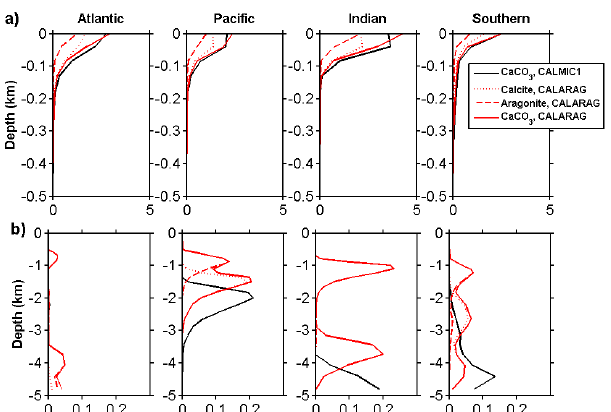
Fig. 6. Depth profiles for (a) CaCO 3 production (µmolkg − 1 yr − 1 ) and (b) open water CaCO 3 dissolution (µmolkg − 1 yr − 1 ) of two versions CALMIC1 (calcite, black) and CALARAG (calcite, arag- onite and total CaCO 3 , red). Production of total CaCO 3 is shown for the upper 500 m, dissolution for the entire water column.